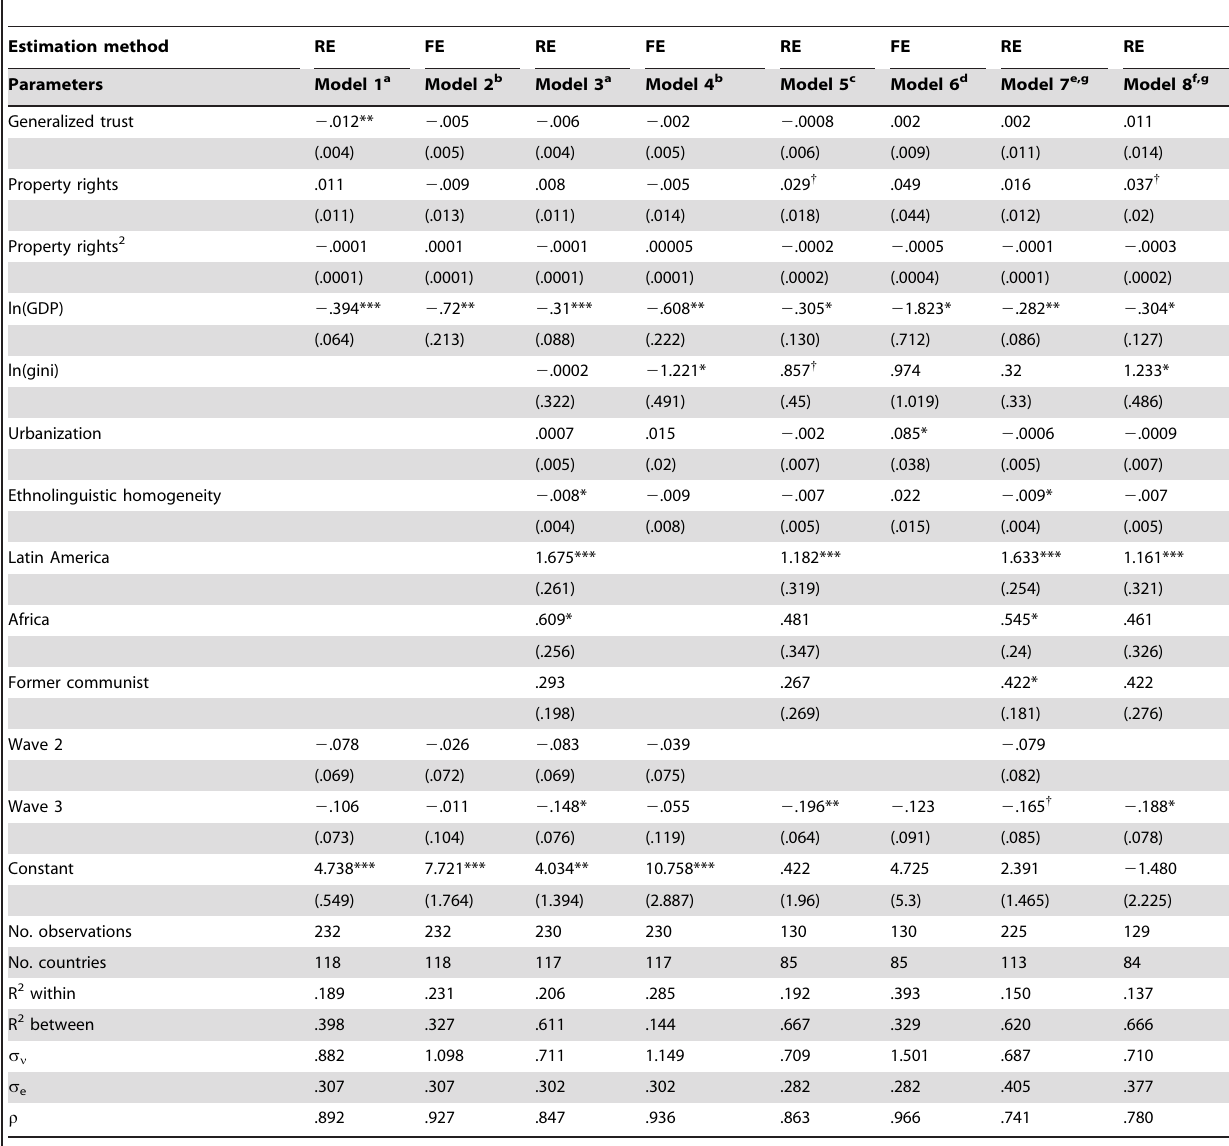
Table 3. Intentional homicide and generalized trust: A fixed- and random-effects panel